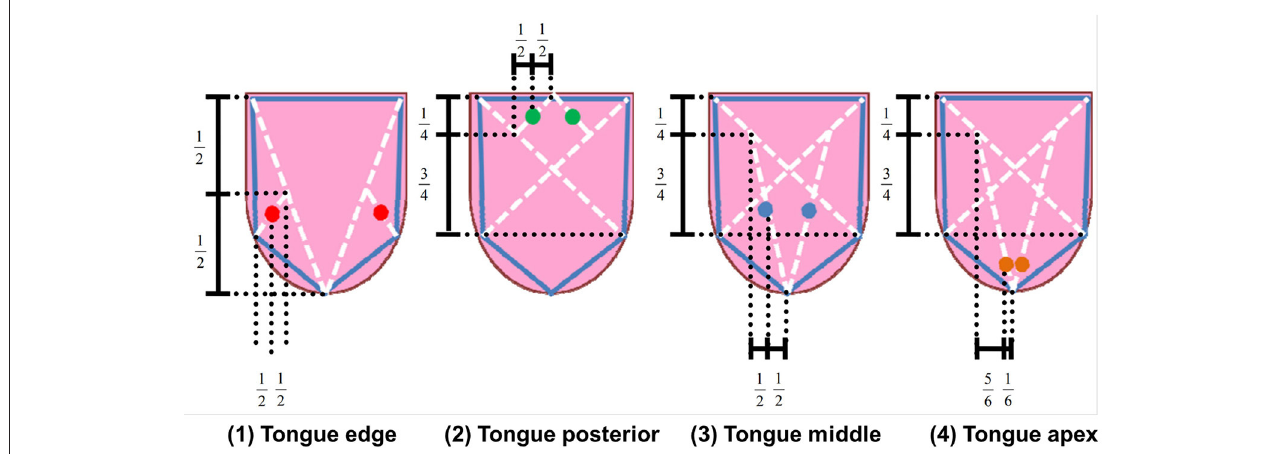
FIGURE 1 | Definition of the four measurement points of the tongue color values.